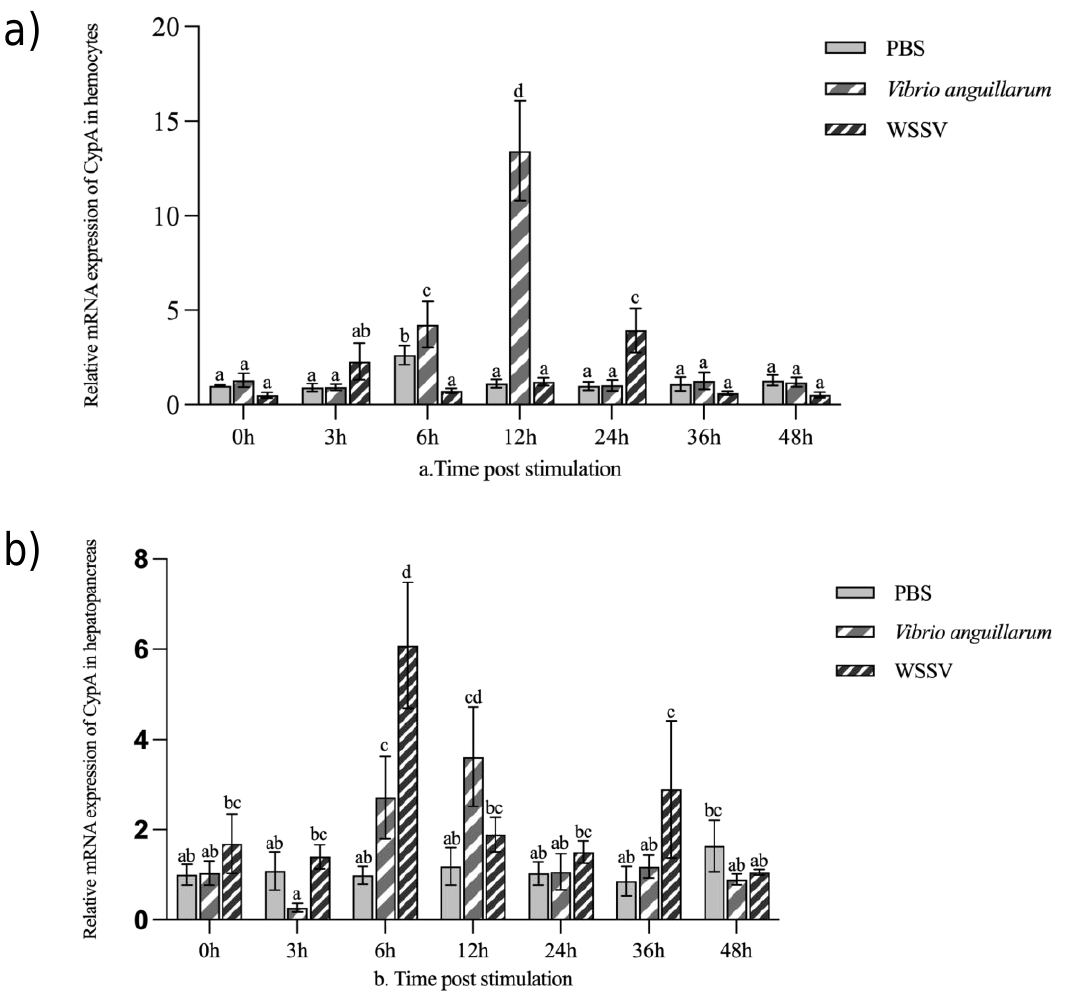
Fig. 5 Relative expression of Fc CypA gene in hemocytes(a) and hepatopancreas(b) after microbe challenge V. anguillarum suspension and WSSV stock. Sampling times at 0, 6, 12, 24, 36, 7 and 48 hr.18S rDNA gene was used as an internal control to calibrate the cDNA template for all the samples. Each vertical bar represents the mean ± SD (n = 5), and Different letters indicate significant differences ( p <